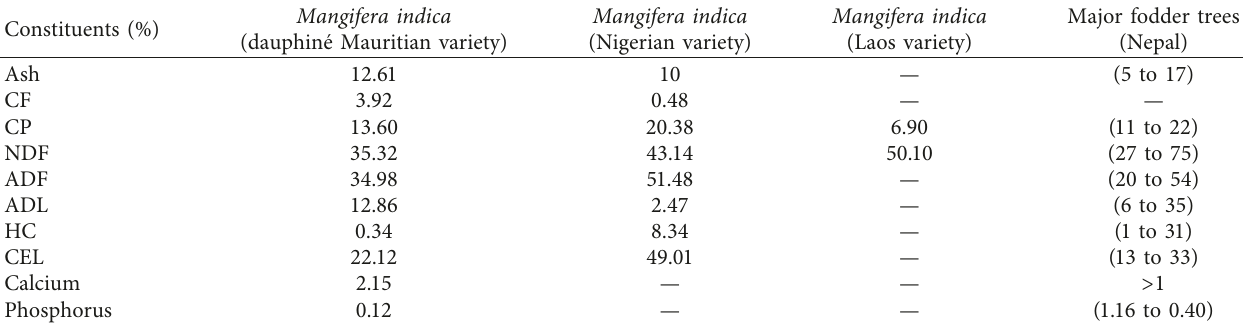
Table 1: Proximal composition expressed in % (dry basis) of Mangifera indica .